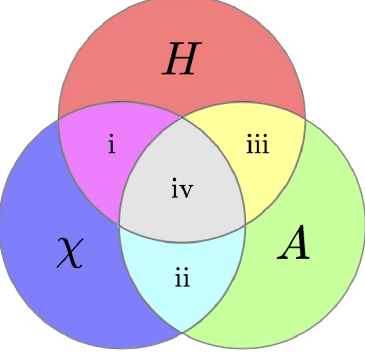
FIG. 1. Hydrodynamics ( H ) and linear response theory ( A ) are well-known techniques to study collective states of matter. Our paper introduces in this context a new perspective based on singulants ( χ ). The main text discusses the meaning of different overlaps between these domains represented as